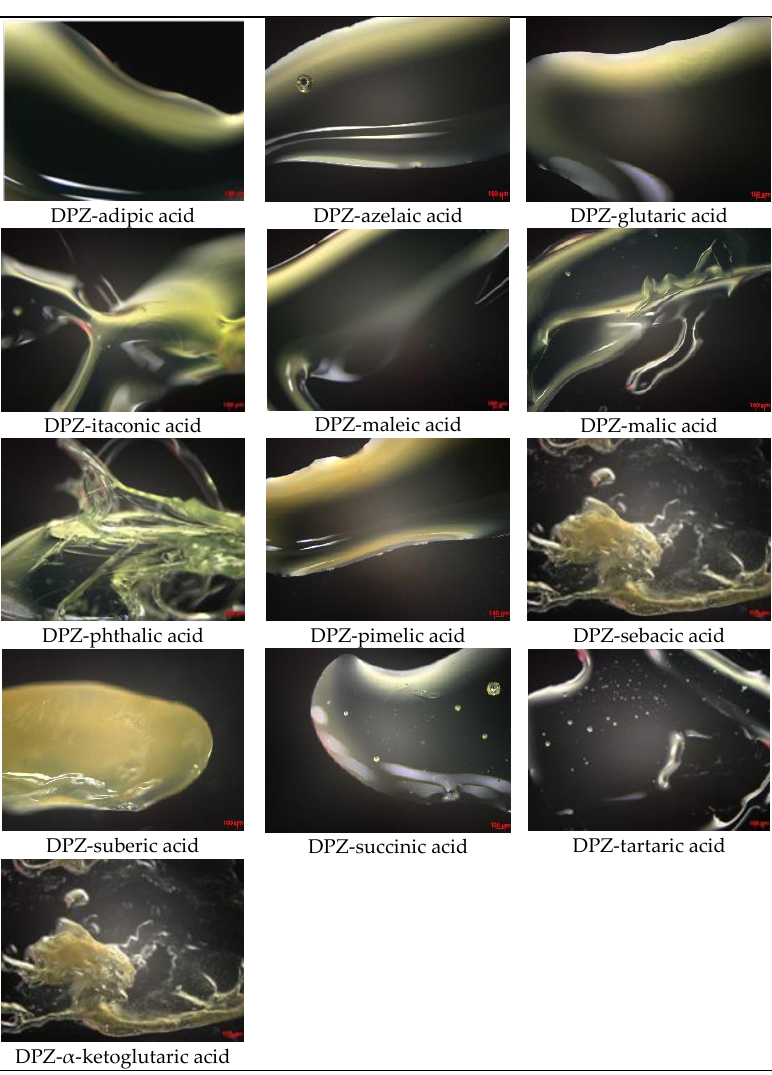
Figure 4. Optical microscopic images of DPZ ILs.